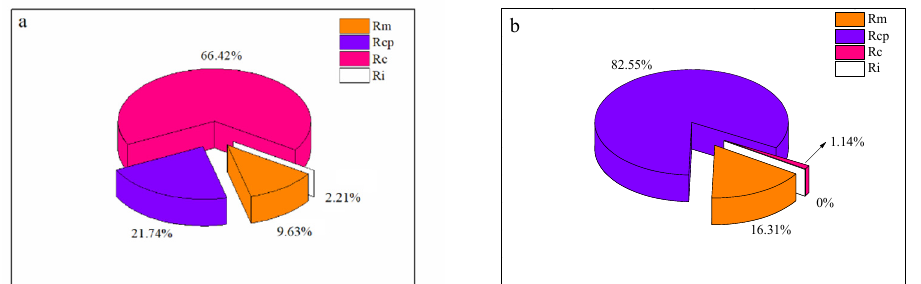
Figure 4. The membrane resistance distribution after 12 h in MBR ( a ) HTR-PVDF, ( b ) HMR-PVDF. Table 3. The flux changes of the HTR-PVDF and HMR-PVDF membrane after12 h in MBR. Items